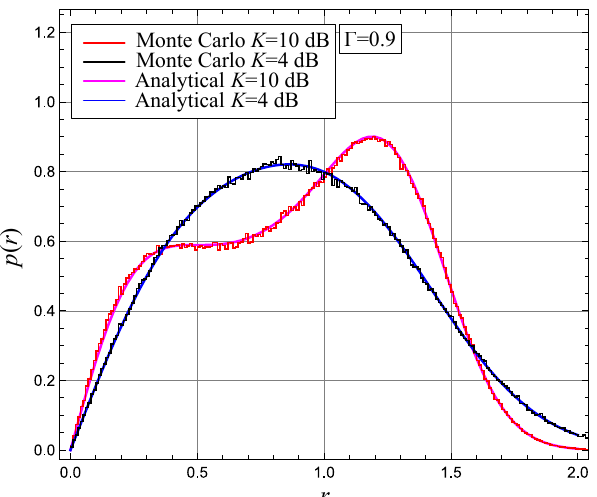
Figure 7. Effect of parameter K on accuracy of evaluating CDF: ( a ) upper bound for truncation error vs. number of terms in summation; ( b ) required number of terms vs. truncation error.